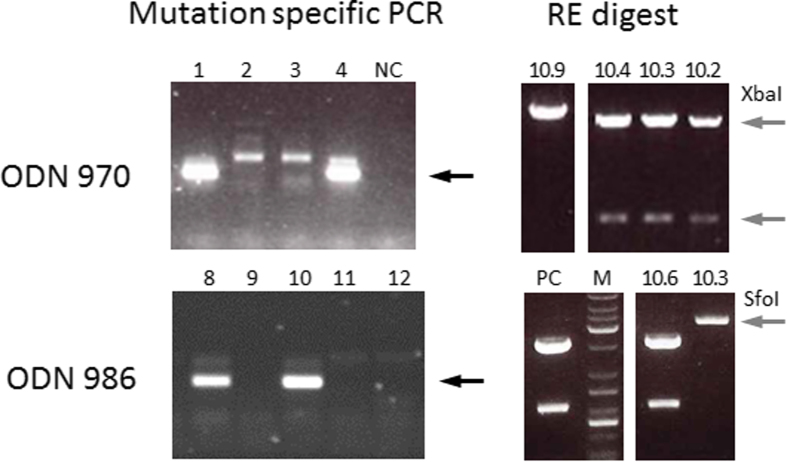
Detection of ODN-mediated genome edits by nested PCR and restriction mapping.Shown are representative examples of PCR results for the second, mutation-specific fragment amplification from individual blastocysts that were co-injected with ZFN and ODN 970 or 986 (left hand panels) at the zygote stage. Black arrows indicate successful amplification that identifies genome-edited embryos. NC: negative control (water). The right hand panels display the result of diagnostic restriction enzyme (RE) digests of different subclones (10.2, 3, 4, 9) derived from embryo 10 co-injected with ZFN/ODN 970 and subclones 10.3 and 10.6 derived from ZFN/ODN 986 injected embryo10. The grey arrows point to diagnostic restriction fragments that differ due to the presence of a new XbaI or absence of a SfoI site in the genome edited allele. PC: positive control (wild type blastocyst) M: DNA size marker.